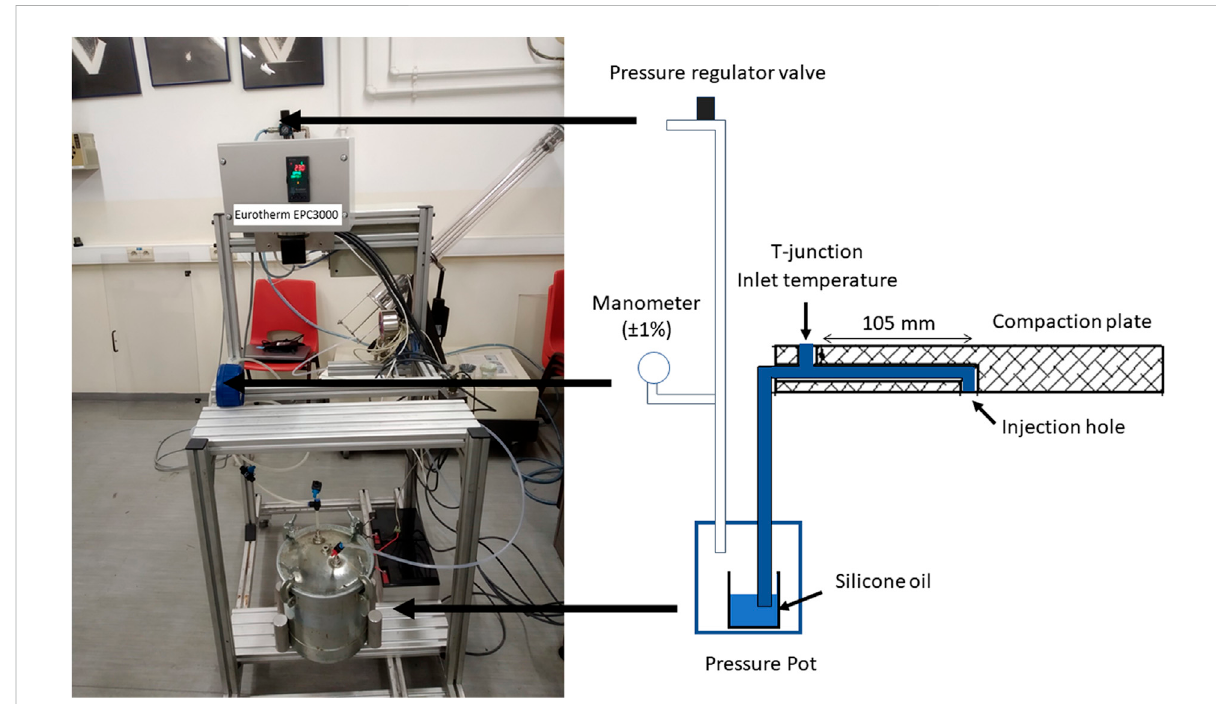
FIGURE 3 Fluidinjectionsystem.Apressurevalveregulatorallowstosetthepressureinsidethepressurepotwiththeaidofacalibrated manometerinthe pressuretubing.Thisvalvealsokeepsthesetpressureconstantbycompensatingsmallpressuredecreases.Intermsoftemperature,ameasurement is made at the compaction plate with a temperature sensor (2-Wire PT1000) at a T-junction in the compaction plate. The resistance value is converted into temperature by a Eurotherm EPC3000 programmable controller that also displays the